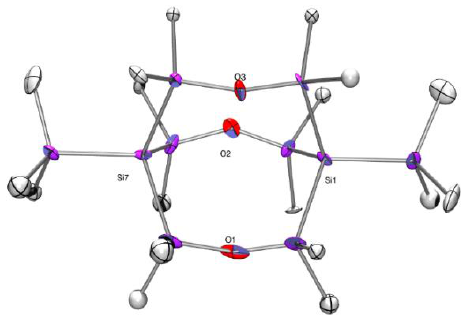
Figure 1. Molecular structure of compound 3 (thermal ellipsoid plot drawn at the 30% probability level). All hydrogen atoms are omitted for clarity (bond lengths in Å, angles in deg). Si(1)-Si(4) 2.3404(18), Si(1)-Si(3) 2.3430(18), Si(1)-Si(2) 2.3486(18), Si(1)-Si(5) 2.3497(18), Si(4)-O(3) 1.641(4),